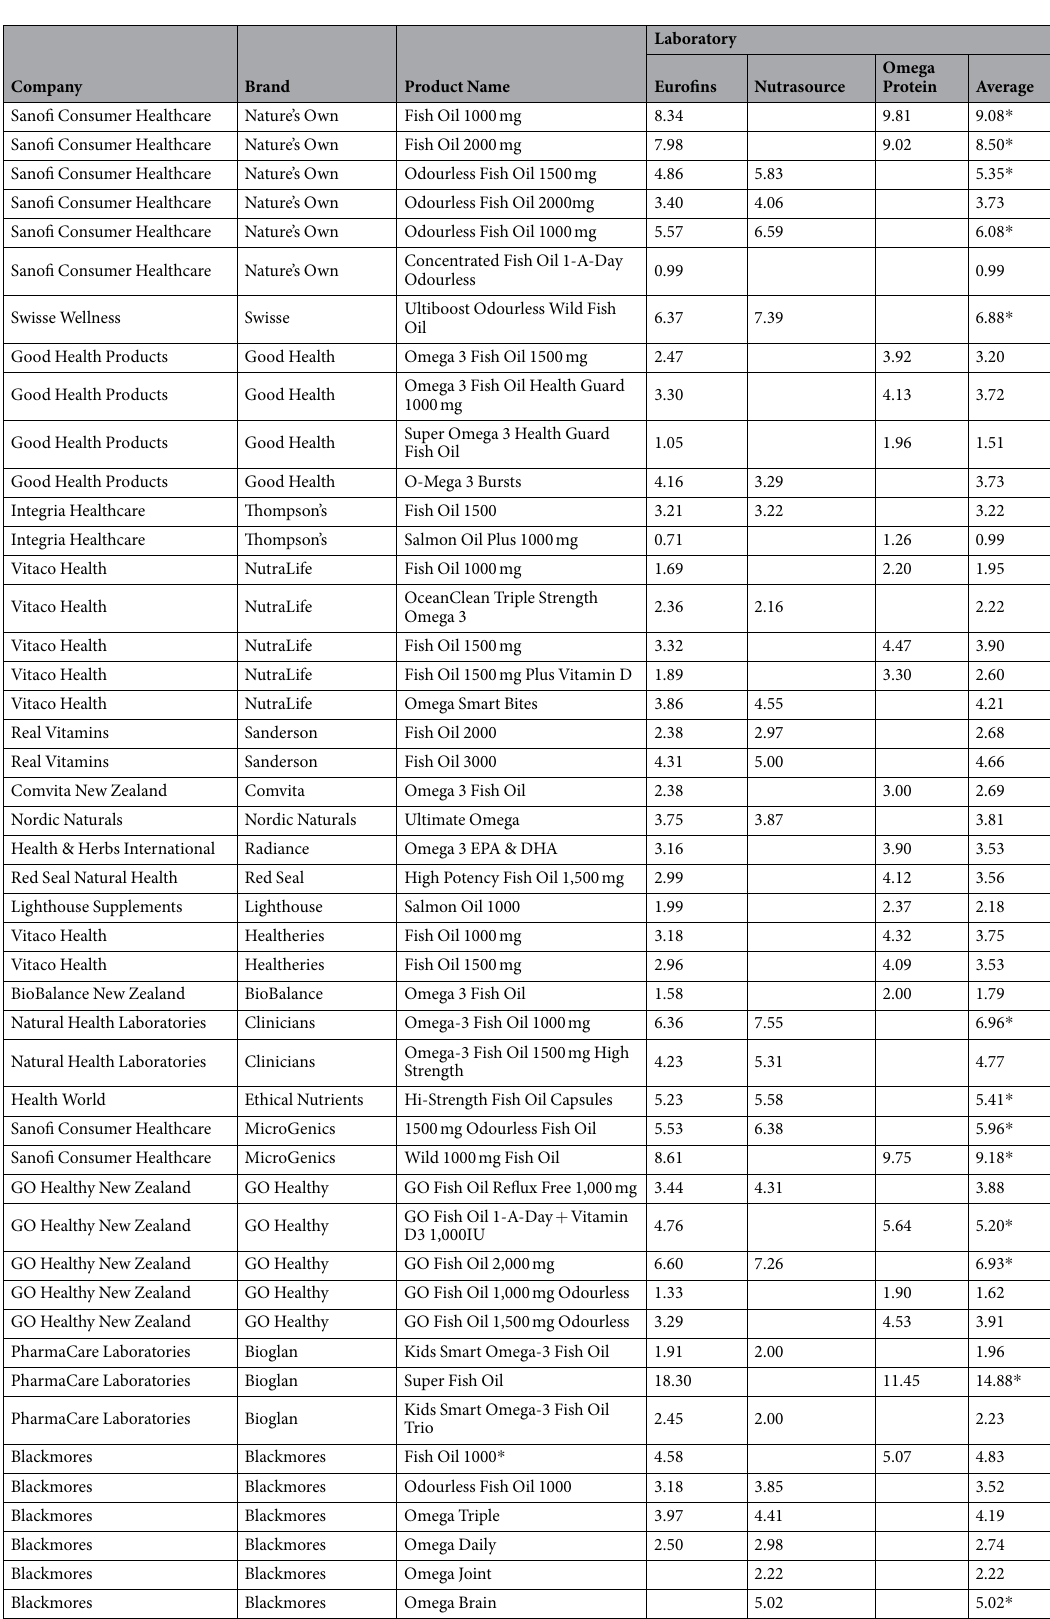
Table 1. Peroxide Value test results (meq O all laboratories exceeded the GOED Voluntary Monograph limit of 5 meq O